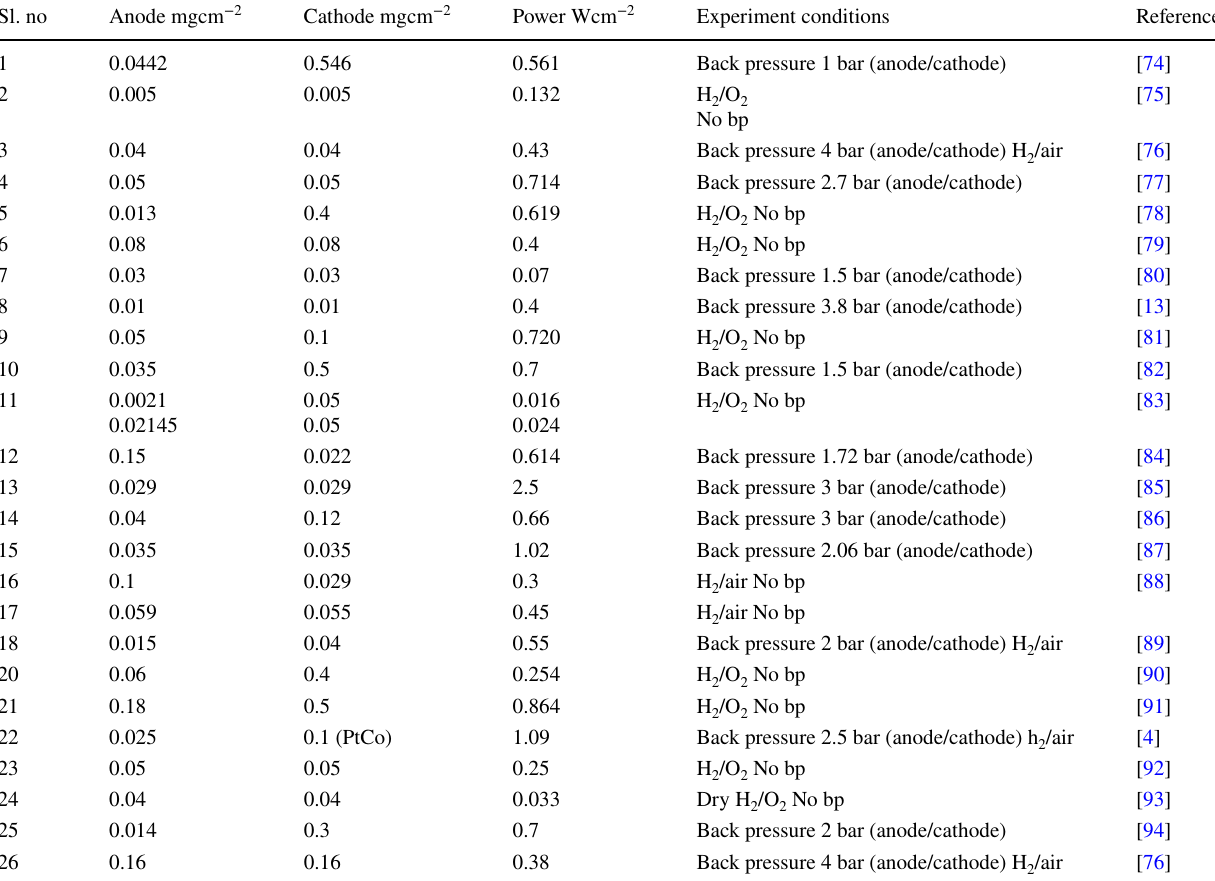
Table 3 Ultra-low loading of anode catalyst